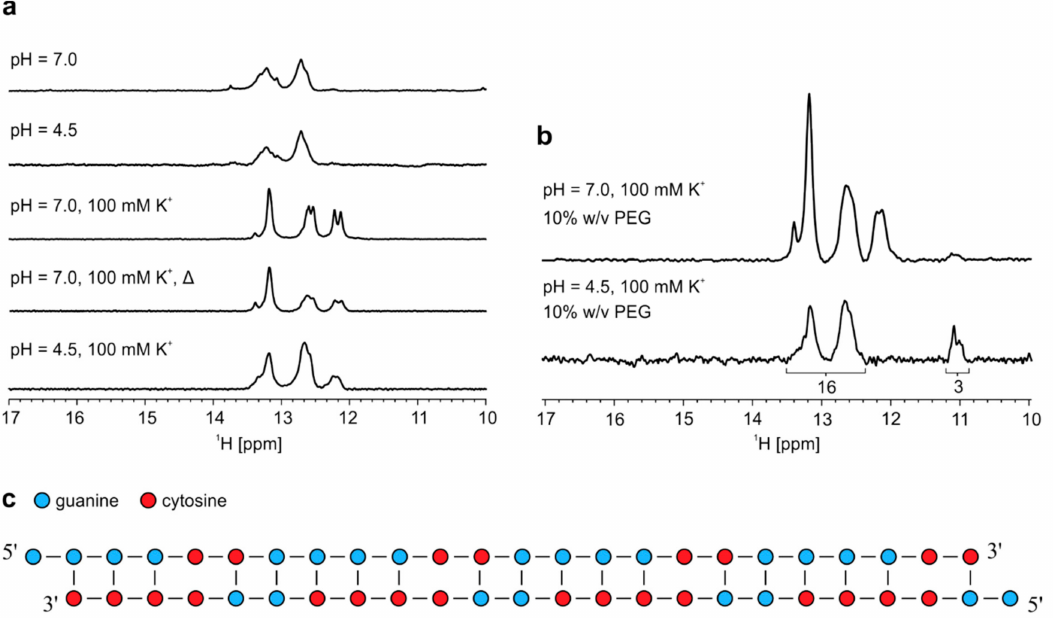
Figure 5. E ff ect of pH, presence of K + ions and PEG on heterodimer. ( a ) 1 H-NMR spectra of annealed equimolar mixture of r(G 4 C 2 ) 4 and r(G 2 C 4 ) 4 . ∆ represents NMR spectrum after second annealing. All spectra were acquired on an 800 MHz NMR spectrometer at 25 ◦ C and 0.2 mM oligonucleotide concentration per strand. ( b ) 1 H-NMR spectra of annealed equimolar mixture of r(G 4 C 2 ) 4 and r(G 2 C 4 ) 4 in the presence of 100 mM K + and PEG at di ff erent pHs acquired at 25 ◦ C and 0.2 mM oligonucleotide concentration per sense and antisense strand. Numbers under signals in the bottom spectrum represent integral values. c ) Proposed model of heterodimer in the presence of 10% w / v PEG at pH